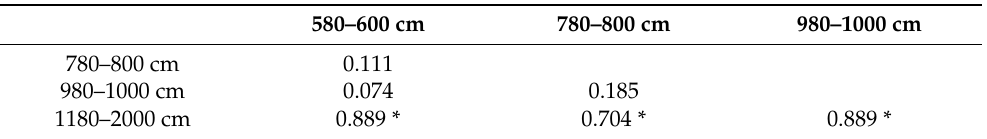
Table 4. Results of one-way unordered ANOSIM: R values Vankervelsvlei (VV; undisturbed peatland) for actinobacteria at different